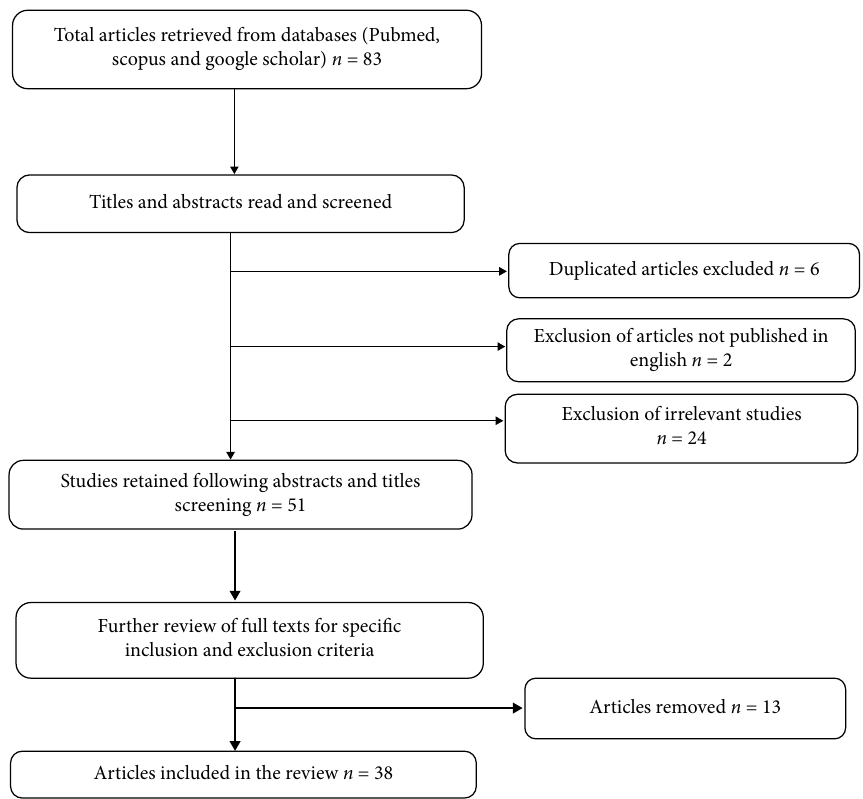
Figure 1: Study selection flow